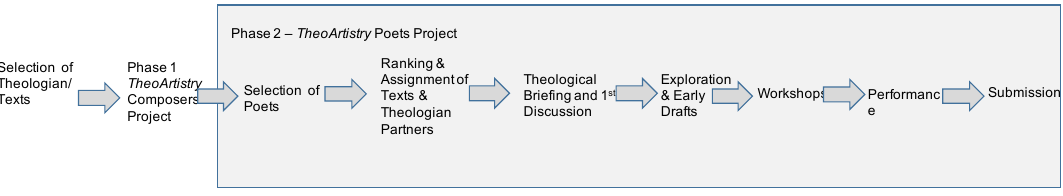
Figure 1. Timeline for the TheoArtistry Poets’ Project The final poem—of no more than 40 lines, and relating to the biblical text—was to be delivered within